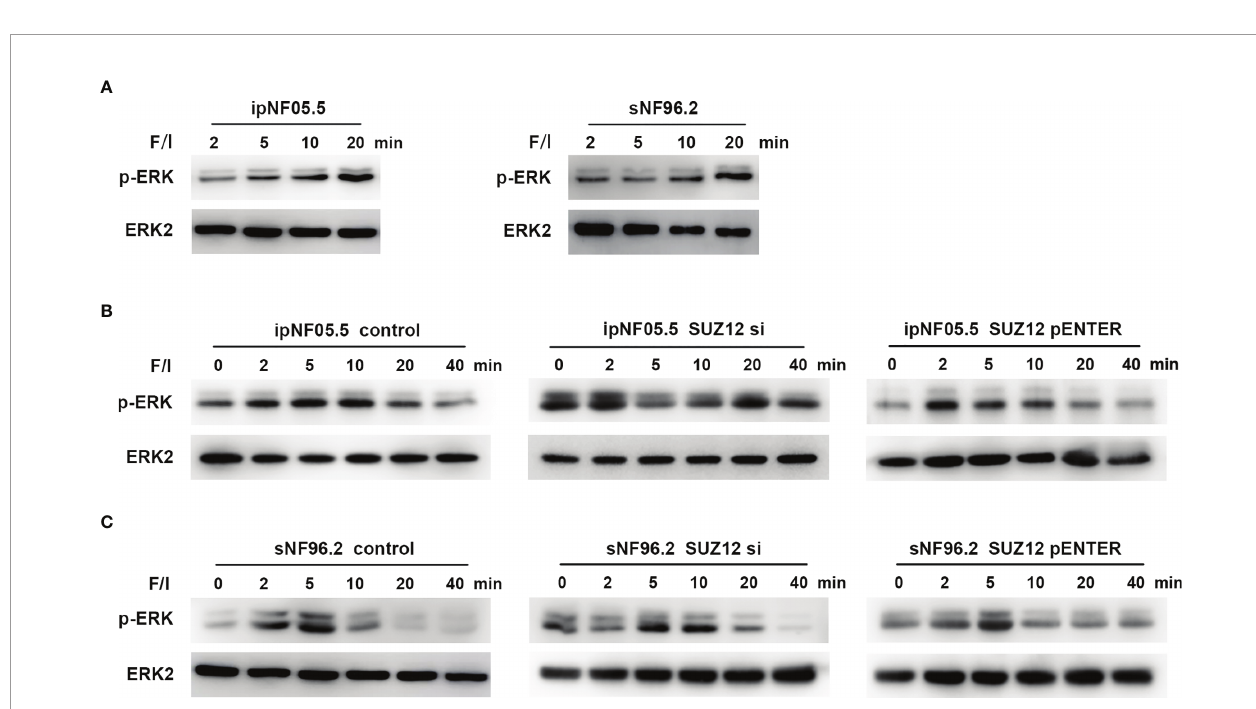
FIGURE 5 | Activation of ADCY1 affects the temporal effect of ERK phosphorylation levels. (A) Western blot showing the activation time of P-ERK after the addition of forskolin and IBMX (F/I) in ipNF05.5 and sNF96.2. (B) Western blot showing changes in p-ERK expression in SUZ12 si and SUZ12 pENTER groups compared with controls in ipNF05.5. (C) Western blot showing changes in p-ERK expression in SUZ12 si and SUZ12 pENTER groups compared with controls in ipNF05.5. ERK2 was used as control in all fi